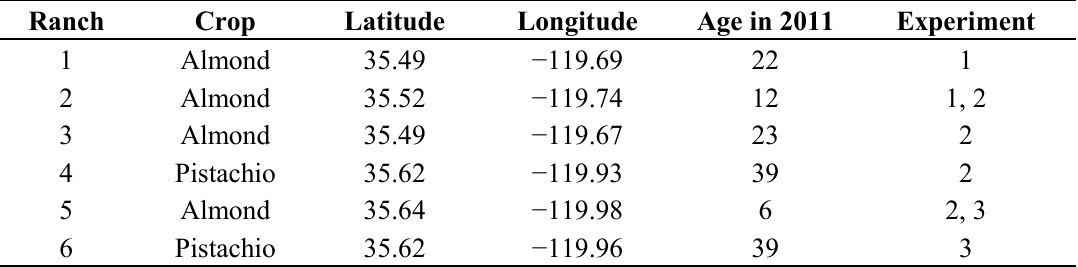
Table 1. Characteristics of experimental